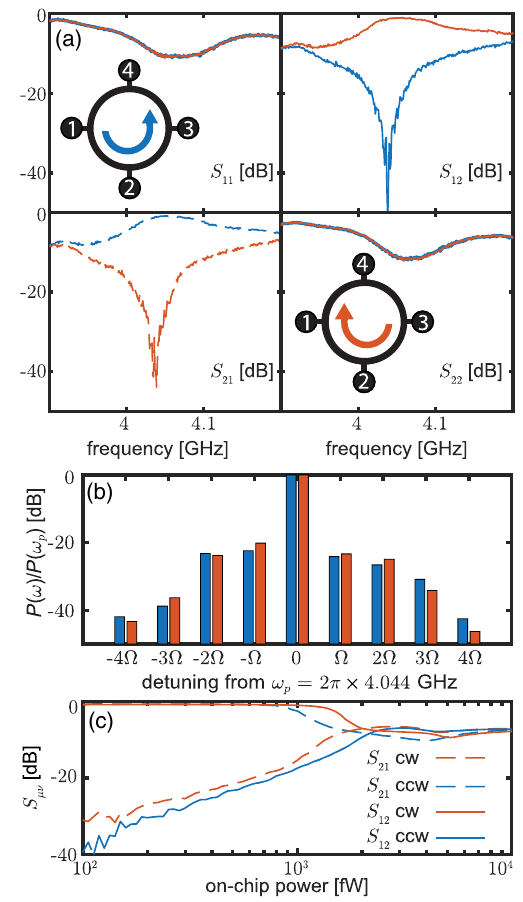
FIG. 6. Performance of an on-chip superconducting circulator tuned to operate near 4 GHz. (a) Frequency dependence of four of the circulator ’ s 16 scattering parameters, when configured as a counterclockwise circulator (blue traces) and a clockwise circu- lator (orange traces). (b) Transmission spectrum of the circulator ¼ 2 π × 4 . 044 GHz, measured at frequencies ω (cid:2) m Ω at ω p p with m a positive integer. Spectral components are normalized by the power transmitted at ω . Spurious sidebands are suppressed p by approximately 20 dB. (c) Transmission as a function of probe ¼ 2 π × 4 . 044 GHz. power, with probe frequency fixed at ω p 1-dB compression occurs around 1